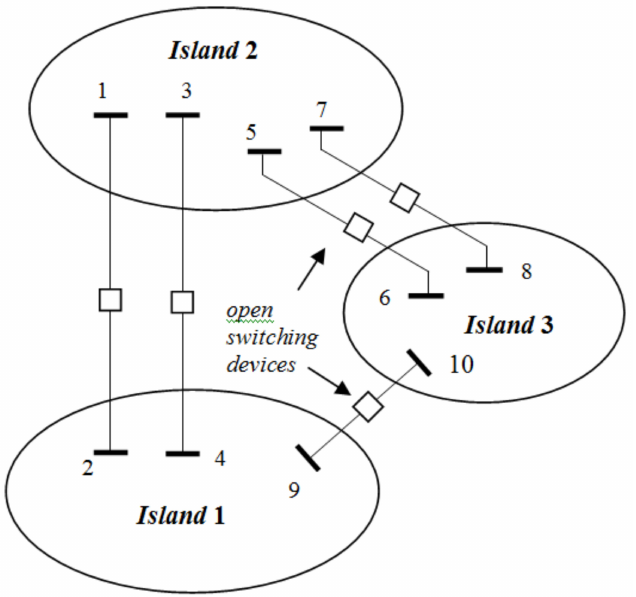
Figure 2. Network splitting considering the open status of switching